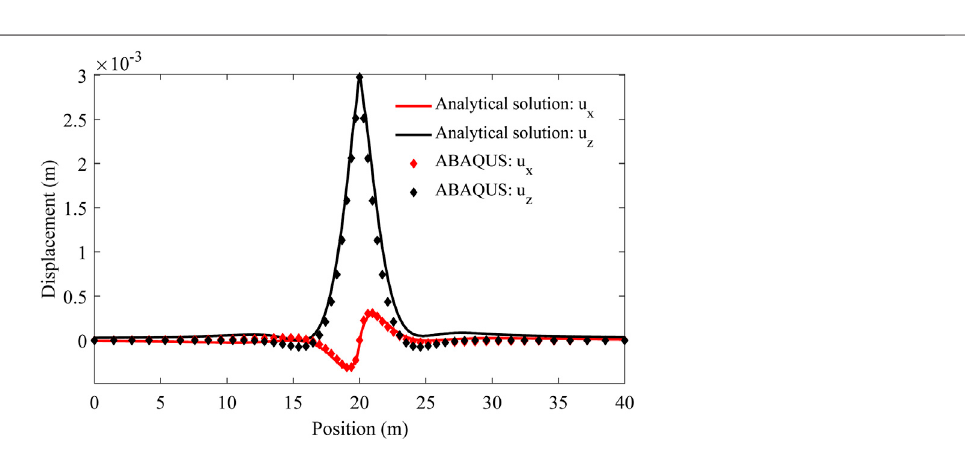
FIGURE 3 | Comparison between the FEM and analytical